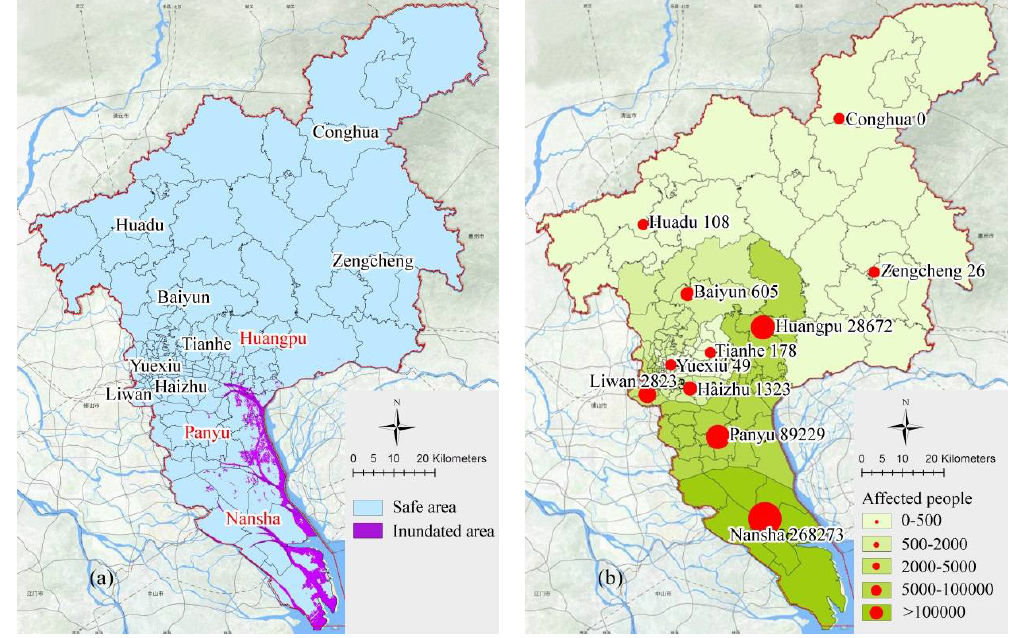
Figure 7. Distribution of ( a ) inundated area and ( b ) affected people during floods. Table 5. Scale of inundated area and affected people during floods, storm surges, and earthquakes.